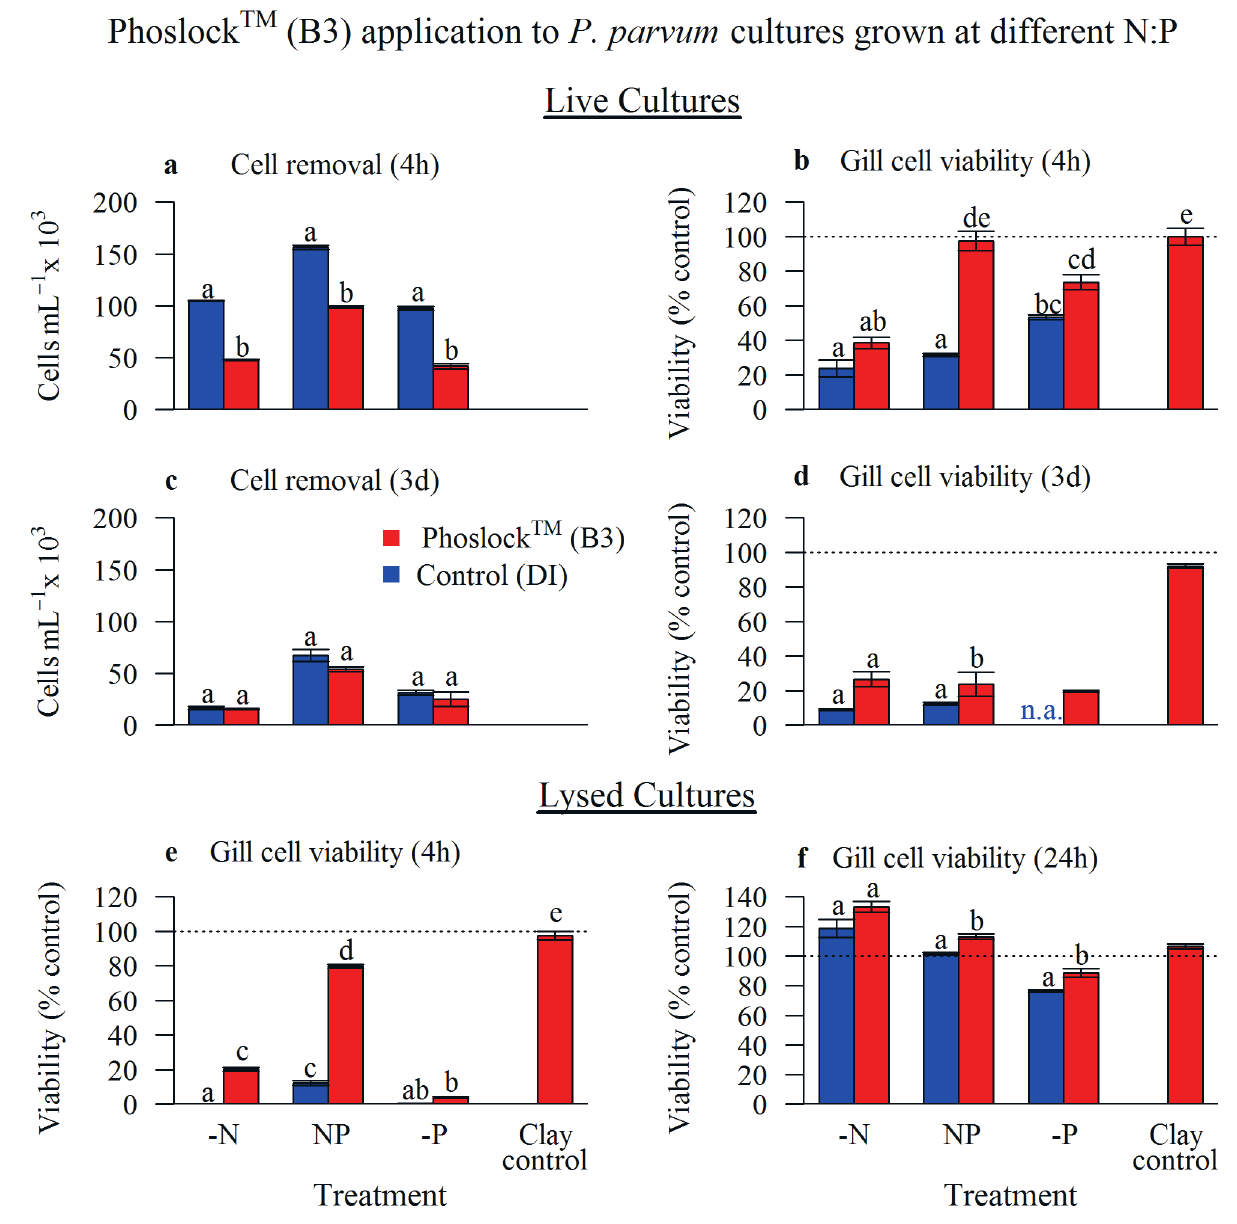
Figure 1. Lanthanum-modified bentonite clay (Phoslock™, B3) application to live and lysed P. parvum cultures grown under different nutrient conditions (nutrient replete, NP; nitrogen deficient, -N; phosphorus deficient, -P). Phoslock™-treated cultures received 1.5 g L − 1 of clay slurry (red bars) and controls an equivalent volume of deionized water (DI, blue bars). ( a ) Cell concentration and toxicity towards the gill cells ( b ) in live cultures 4 h after clay application. ( c ) Cell concentration in live cultures and toxicity towards the gill cell line RTgill-W1 ( d ) three days after clay treatment. ( e , f ) Toxicity of lysed P. parvum towards the gill cells 4 and 24 h after clay treatment. Letters represent significant differences between control and clay treatments within each nutrient condition (a,c,d,f; Welch’s T-test) or between all treatment conditions (b,e; Tukey’s HSD). n.a.: not